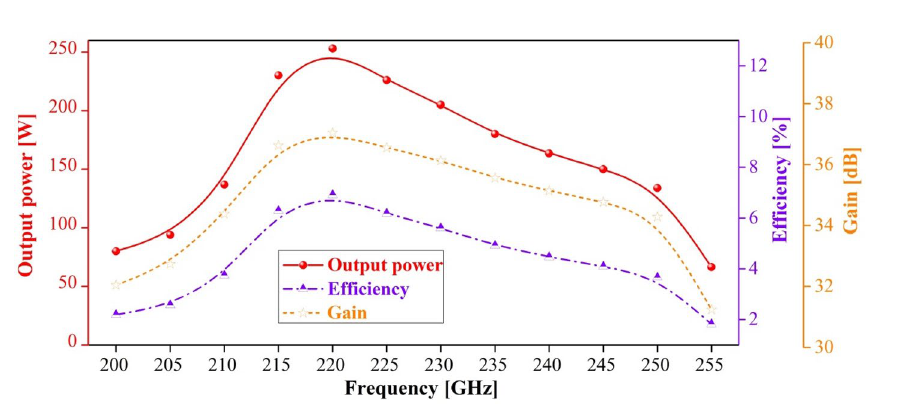
Figure 14. Output power, efficiency and gain of the PWSWG TWT versus